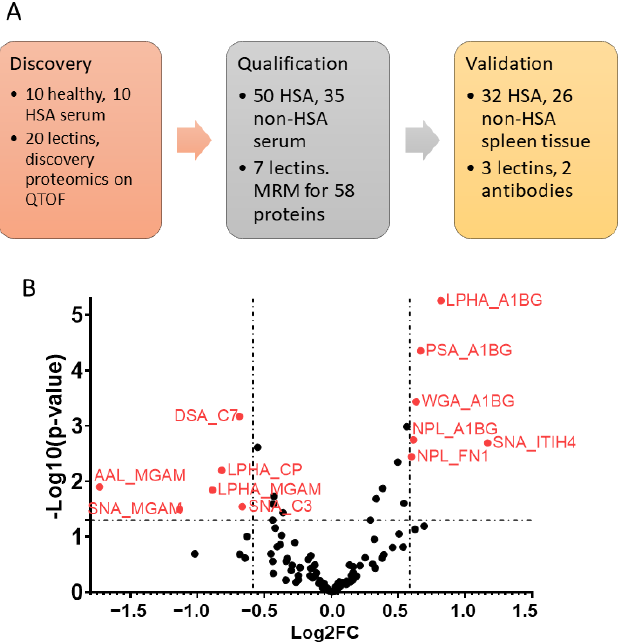
Figure 1. Serum biomarker discovery and validation workflow for canine hemangiosarcoma (HSA). ( A ) Sample numbers and approaches for each biomarker phase. ( B ) Volcano plot of serum biomarker candidate validation by LeMBA-MRM-MS. The candidates with 1.5-fold change and p -value < 0.05 are highlighted.